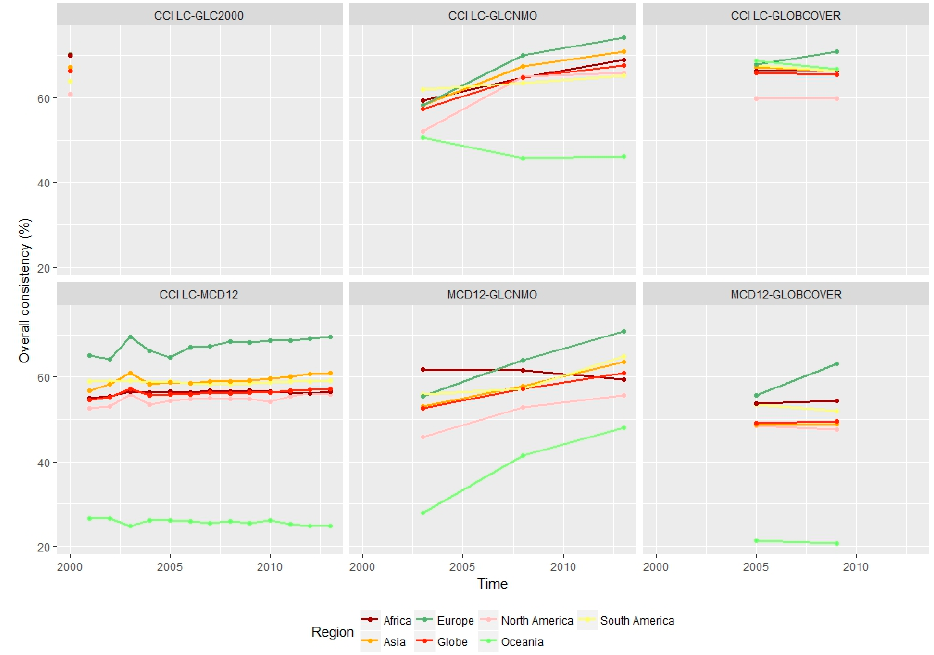
Figure 1. Overall consistency at the global and continental scales.